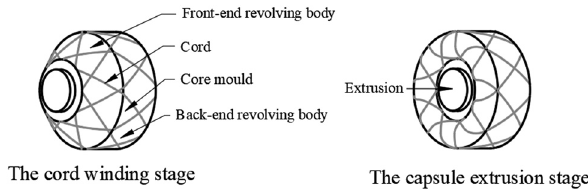
Figure 2: The main forming process of the air spring.